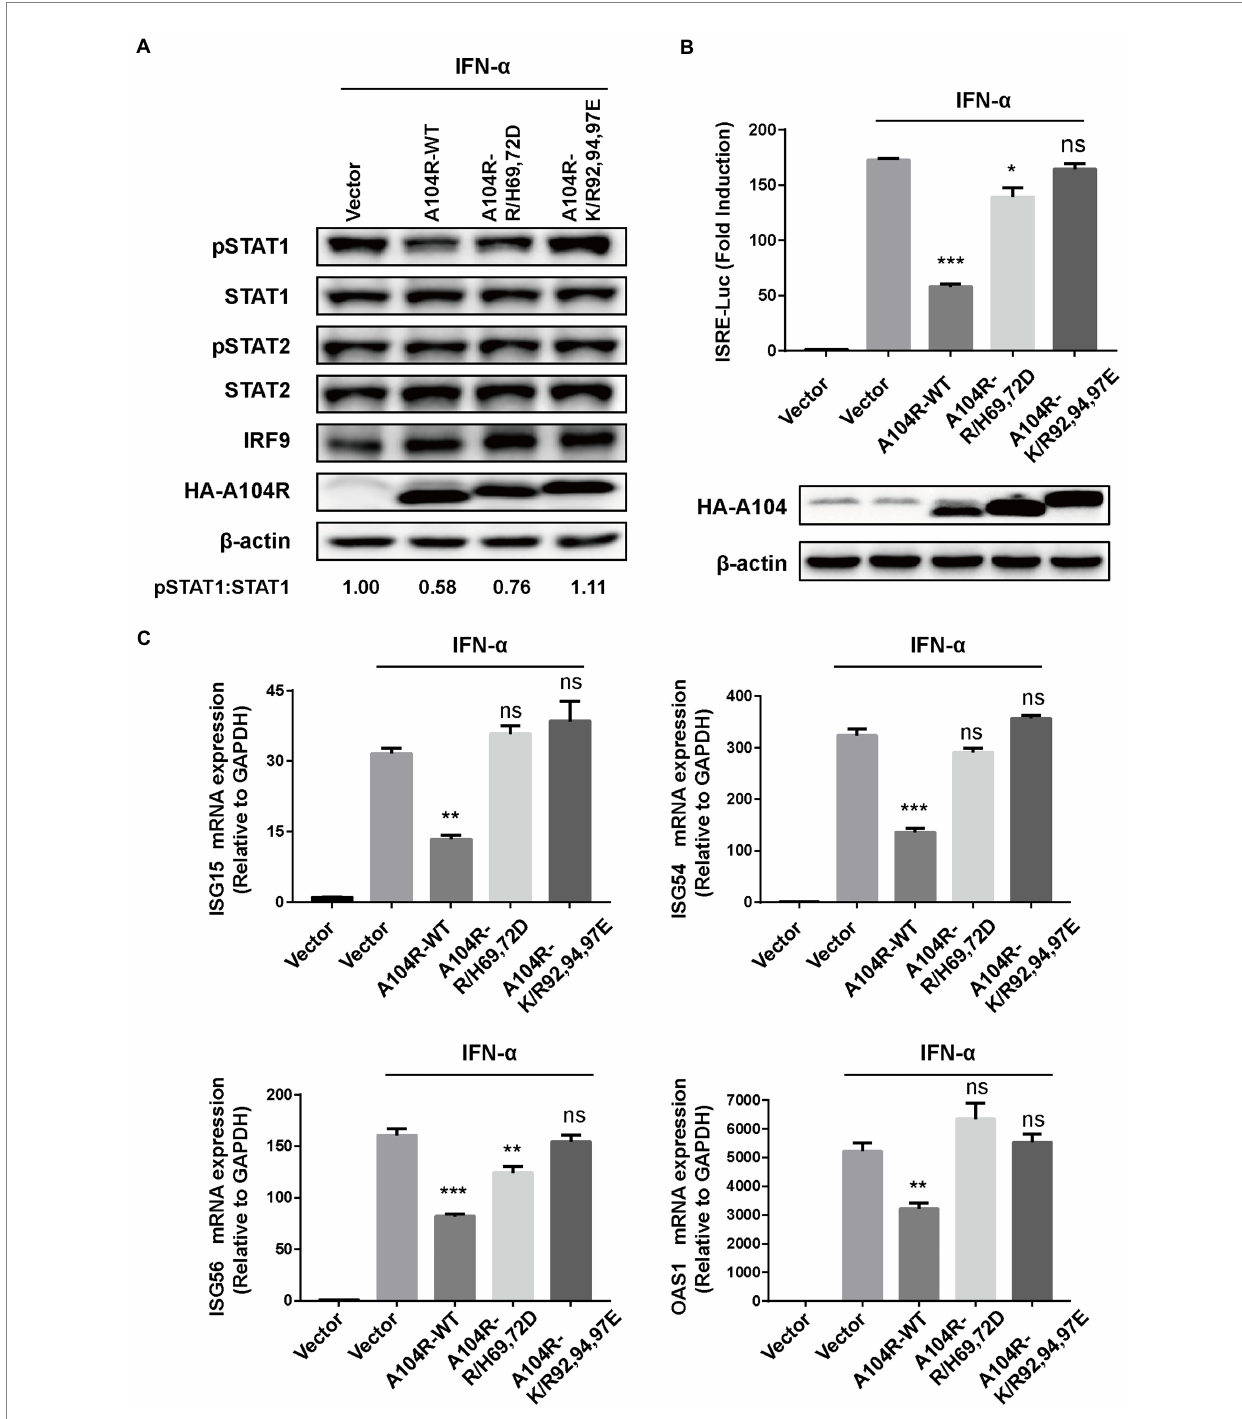
FIGURE 4 ASFV pA104R-Mediated Inhibition of IFN-I signaling is associated with its DNA-binding catalytic residues. Cells were transfected with pA104R or its DNA-binding activity-defective mutants. After 24 h, cells were treated with 1,000 U/mL IFN- α for 2 h (A) , 8 h (B) , or 12 h (C) . Cell lysates were used for immunoblotting analysis with the indicated antibodies (A) , used for luciferase assay (B) , or used for analyzing the mRNA levels of ISGs (C) . Data are shown as means ± SEM from three independent experiments. Statistical analysis was performed by one-way ANOVA. * p < 0.05; ** p < 0.01; *** p <